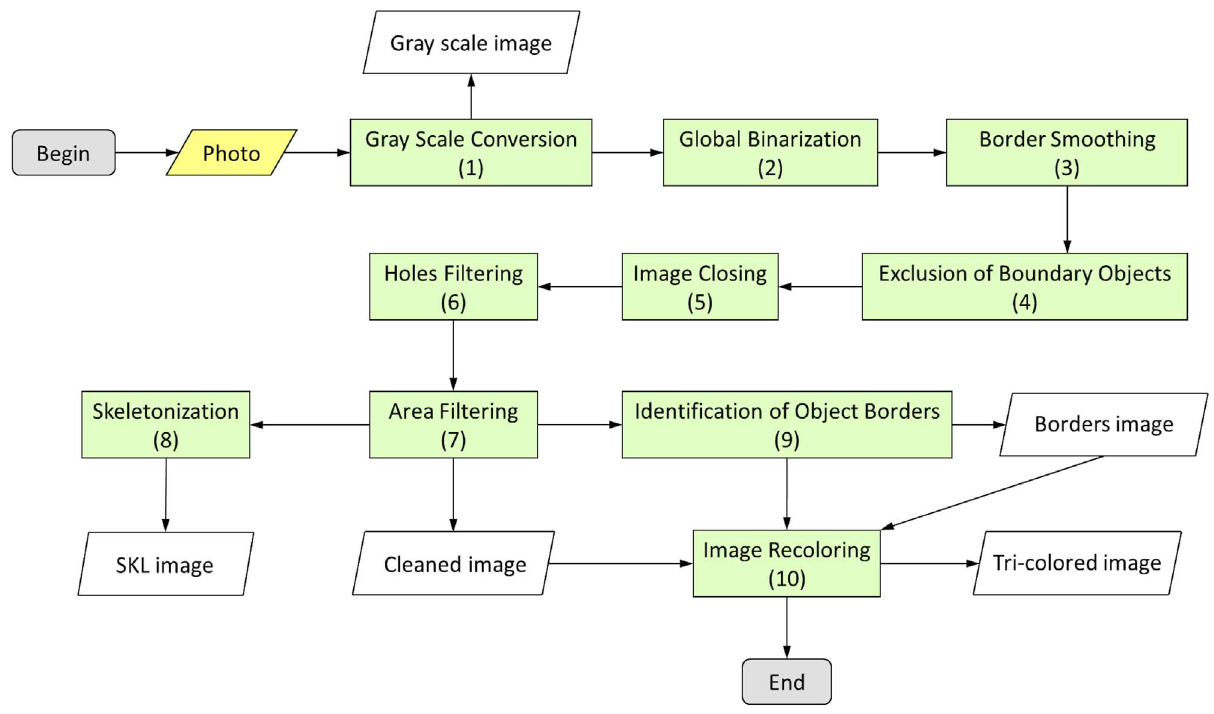
Figure 3. Flowchart of the image processing algorithm. The original photo (in yellow), is processed by the ‘image processing algorithm’ (in green). The numbers inside the green boxes correspond to the steps described in the manuscript. Five images are obtained: Gray scale image, SKL image, Borders image, Cleaned image and finally the Tri-colored image, which is built using the Cleaned image and Borders image.